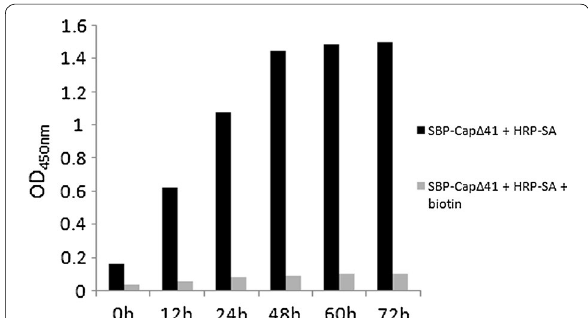
Fig. 6 Effect of biotin on measurement of antibody by HBDS‑ELISA. The biotin was added to a final concentration of 2.8 equimolar with